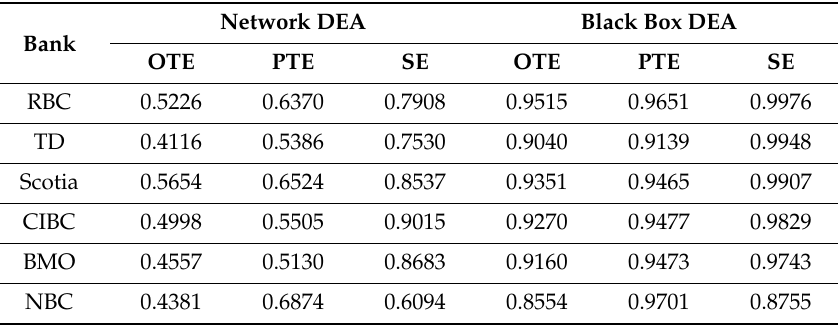
Table 8. Network Data Envelopment Analysis (DEA) vs. black box